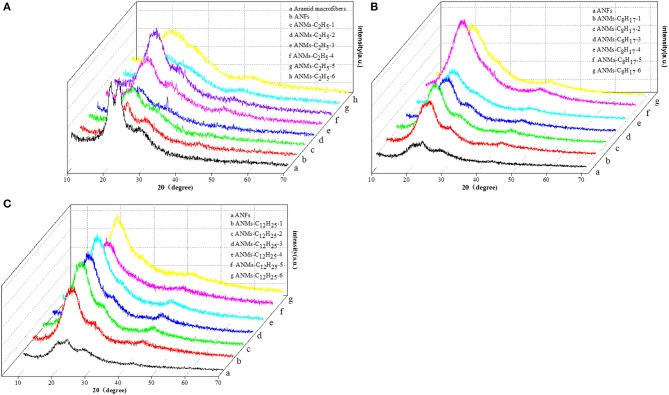
XRD patterns of (A) PPTA, ANFs, and ANMs-C2H5-X, (B) ANFs and ANMs-C8H17-X, (C) ANFs and ANMs-C12H25-X.